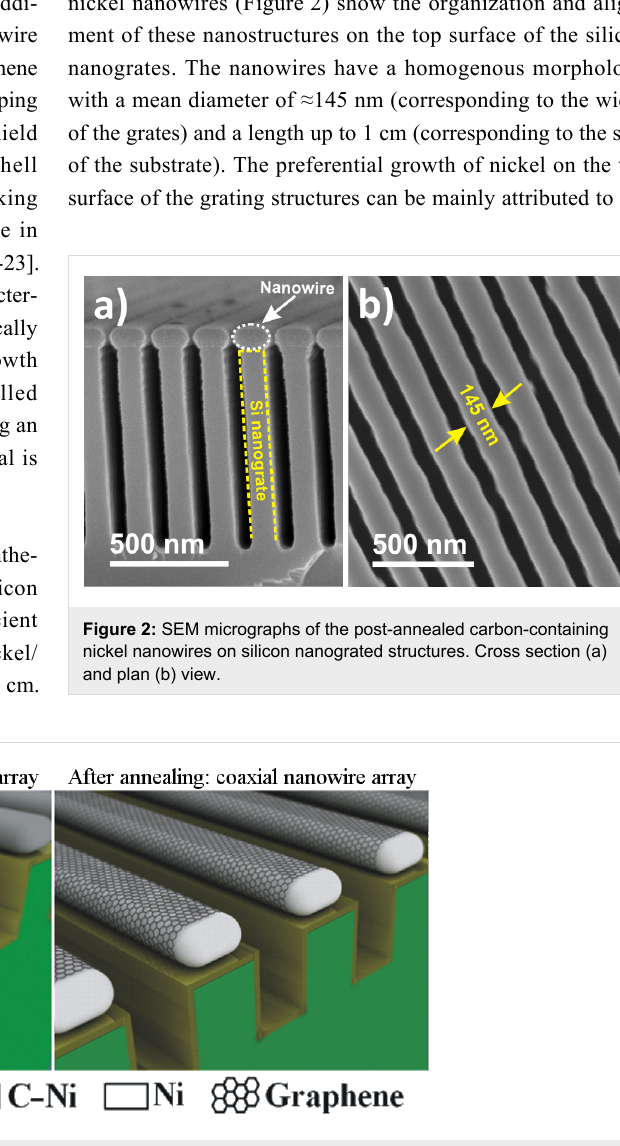
scopic scale. In addition, the manipulation of such one-dimen- sional (1D) nanostructures is often considered as a complicated process and a barrier for a simple integration of nanowires into electrical devices.